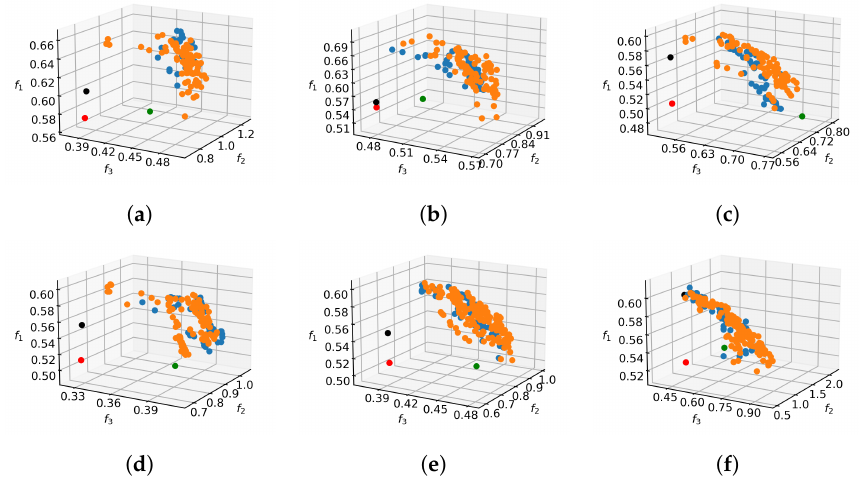
Figure 8. Non-dominated sets obtained by MOEA/D-EAM (blue) and SPEA2 (orange) for the corresponding trees from Figure 6. The plots include reference objective vectors for no pruning (red), cylindrical pruning (green), and rule-based pruning (black).